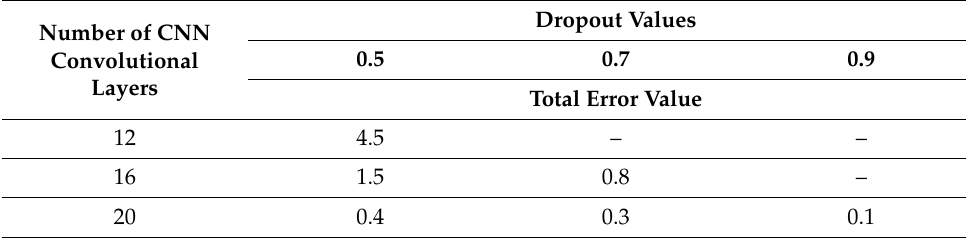
Table 4. Total error of the CNN models with